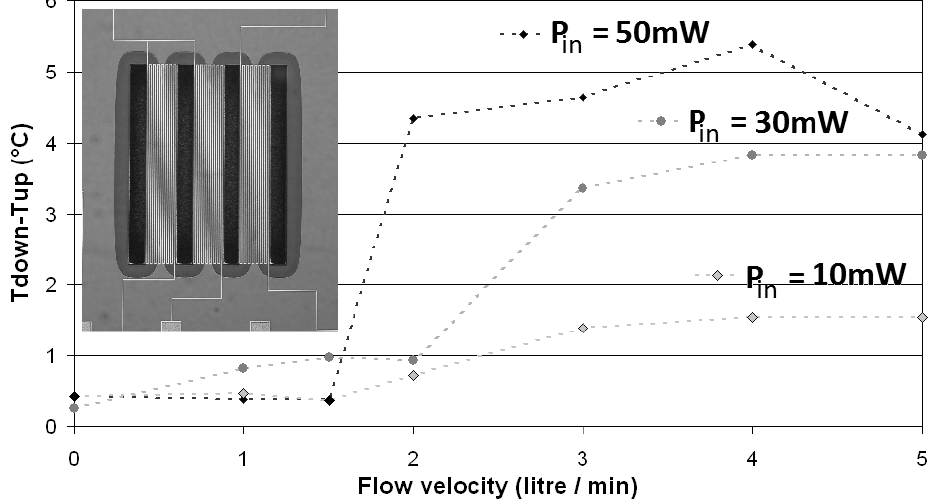
Figure 13. Determination of the flow direction and velocity with a three-structure sensor.